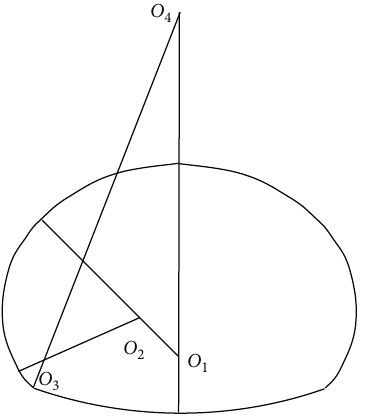
Figure 2: Cross-section of the